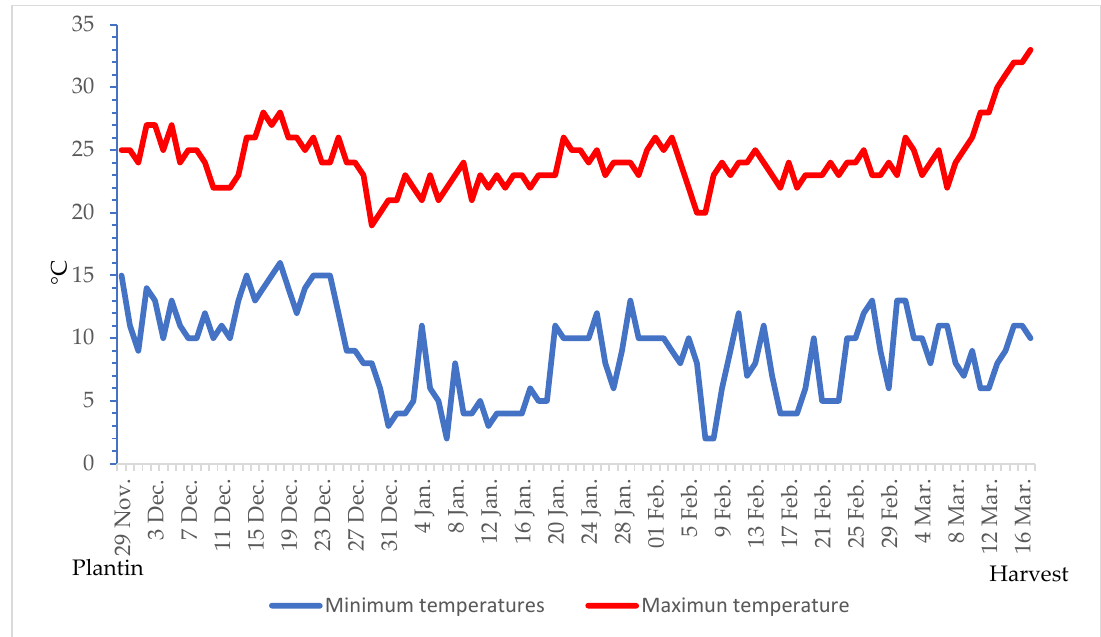
Figure 2. Minimum and maximum air temperature inside a tunnel located in Marsala, Trapani province (longitude 12°26’ E, latitude 37°47’ N, altitude 37 m) during the celery growing cycle. “Malachit” F 1 (RBsementi, Torin, Italy) celery